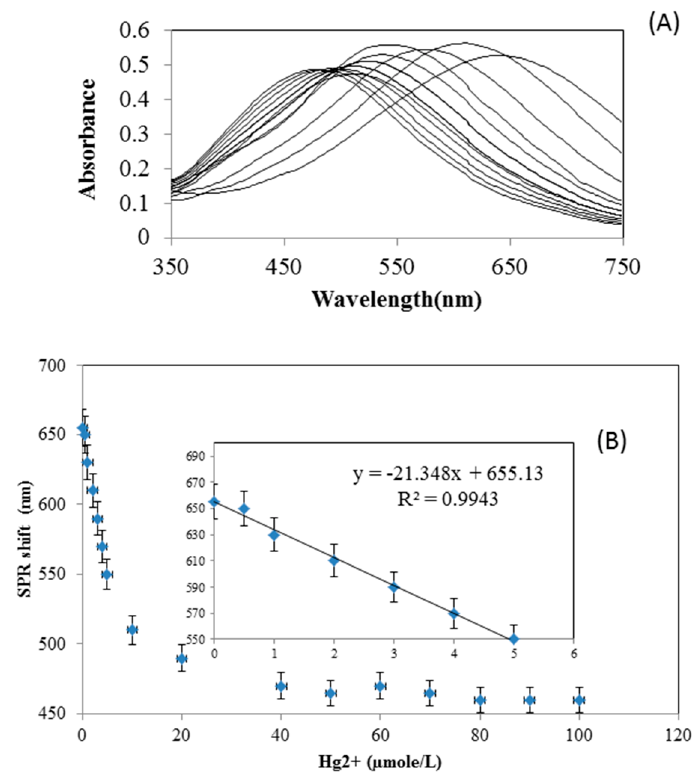
Figure 8. ( A ) UV − visible absorption spectra of the AgNPs after the addition of Hg 2 + at various concentrations, with the peak shifting from the right (for 0 µ M) to left as Hg 2 + concentration increases up to 100 µ M. ( B ) Peak wavelength of the AgNPs at varying concentrations of Hg 2 + (0 − 100 µ M), where the inset graph shows a linear regression for the range of 0 to 5 µ M. The error bars show standard deviations (three measurements).